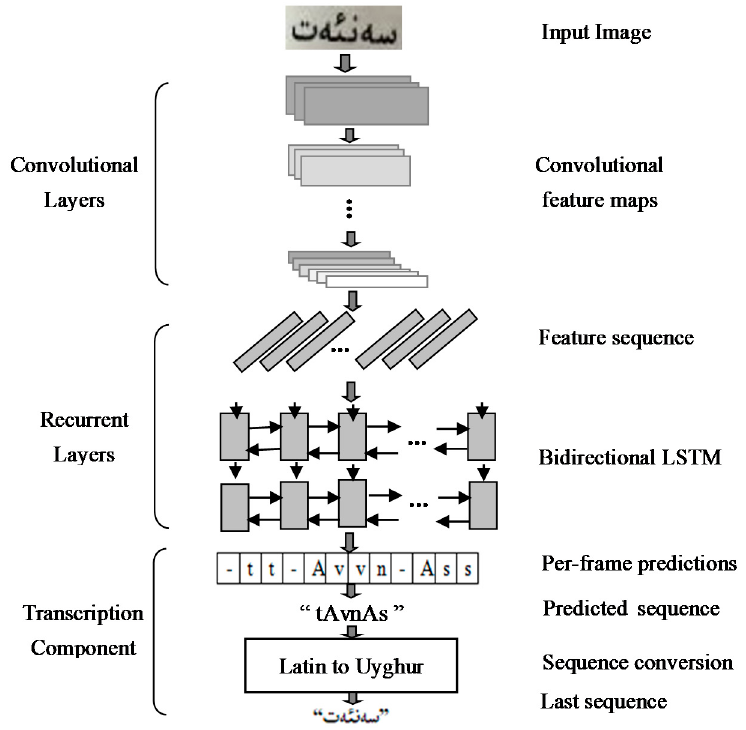
Figure 3. The network architecture of Uyghur text recognition based on improvement CRNN.